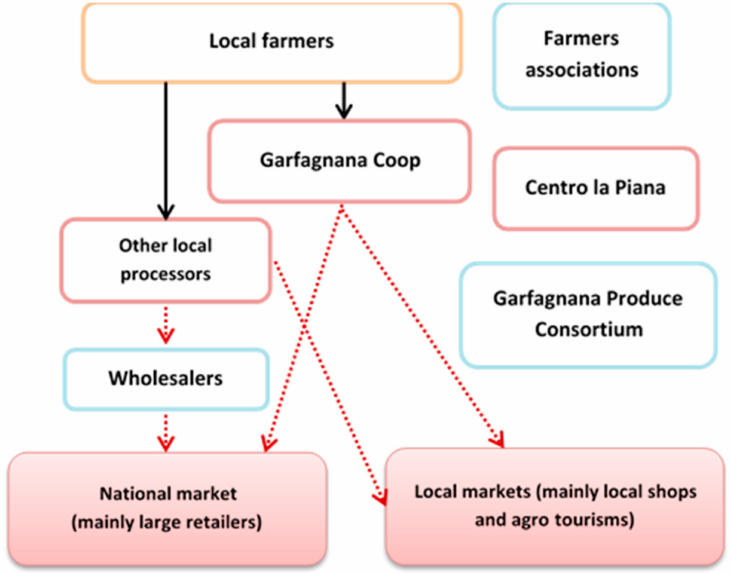
Figure 2. The structure of the agri-food supply chain in